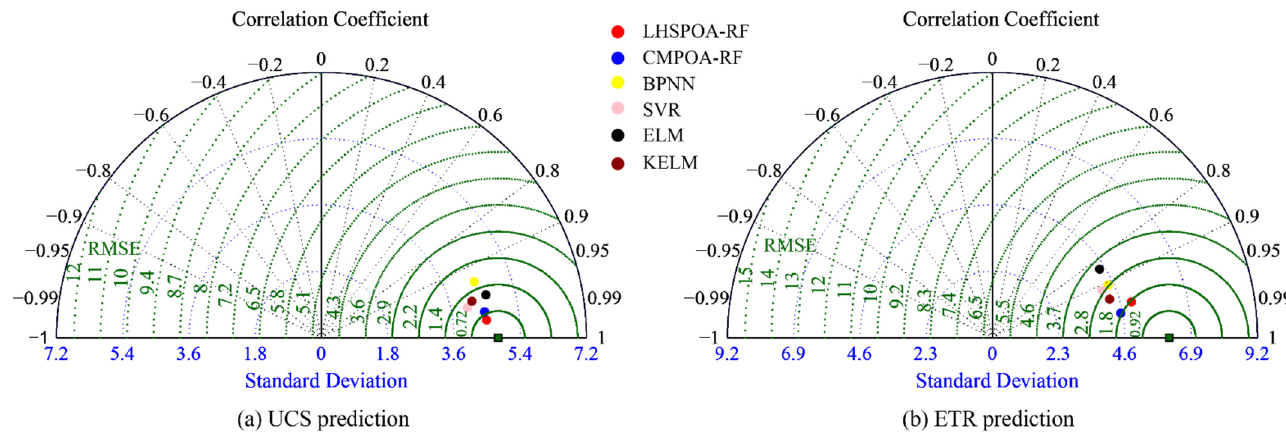
Figure 9. The Taylor diagrams of all models for predicting the UCS and ETR of novel material.